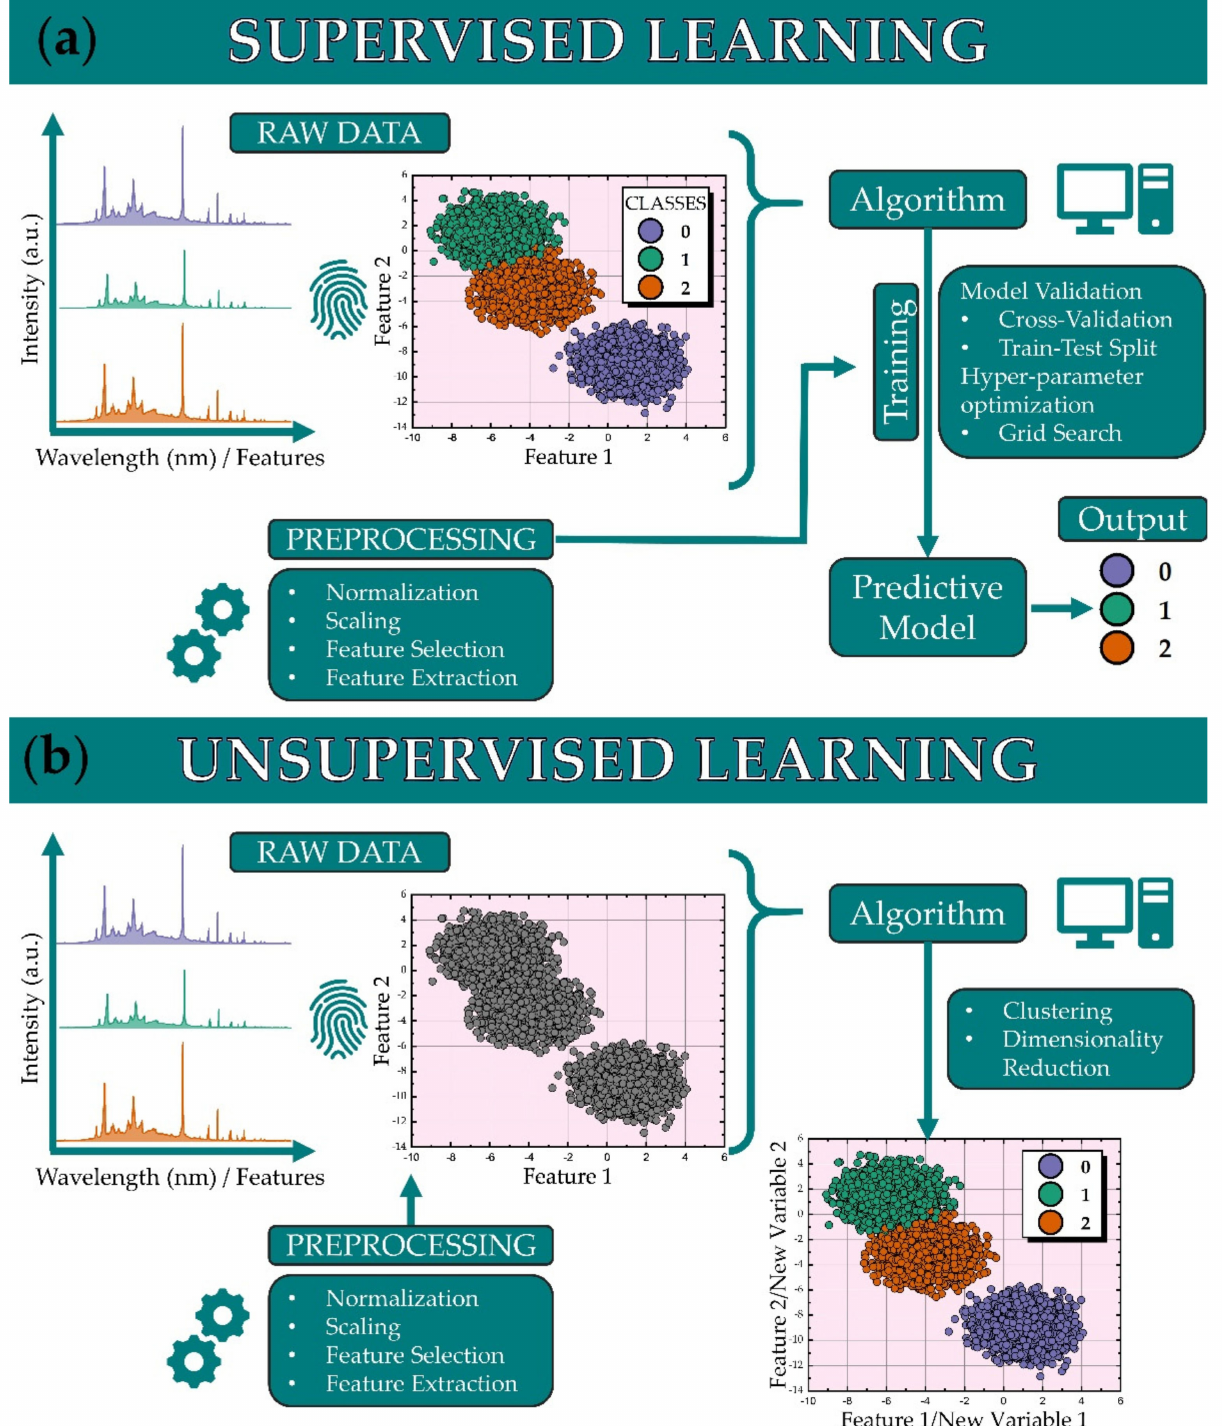
Figure 2. ( a ) Schematic of supervised and ( b ) unsupervised learning algorithmic